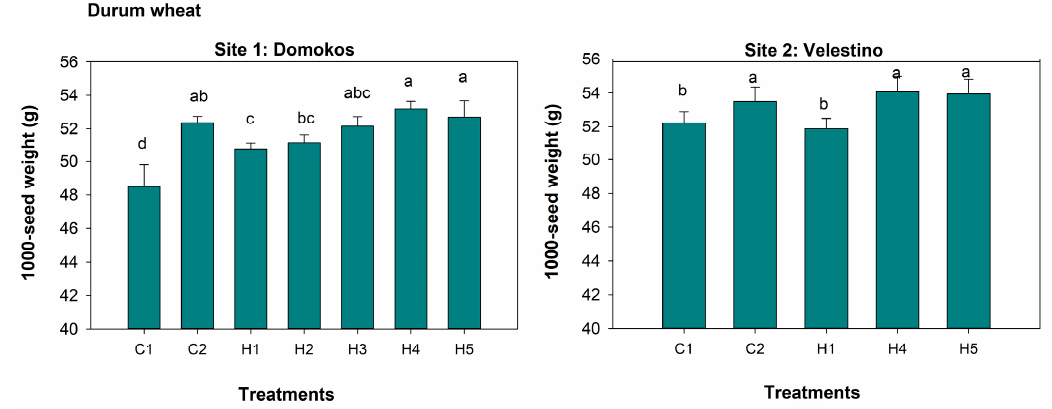
Figure 9. Herbicide treatment (C1: untreated control, C2: weed-free control, H1: metsulfuron-methyl + bensulfuron-methyl, H2: pyroxsulam/florasulam + 2,4-D, H3: aminopyralid + florasulam, H4: bromoxynil + 2,4-D, and H5: halauxifen-methyl + florasulam) effects on 1000-seed weight (g) at two sites. Values are presented as means of three replicates ± standard deviation. Mean values followed by different letters have statistically significant differences according to Duncan’s multiple range test at p < 0.05. F values of ANOVA: F = 12.944 *** (Site 1: Domokos) and F= 7.262 ** (Site 2: Velestino). ** and *** significant at p < 0.01 and p < 0.001.